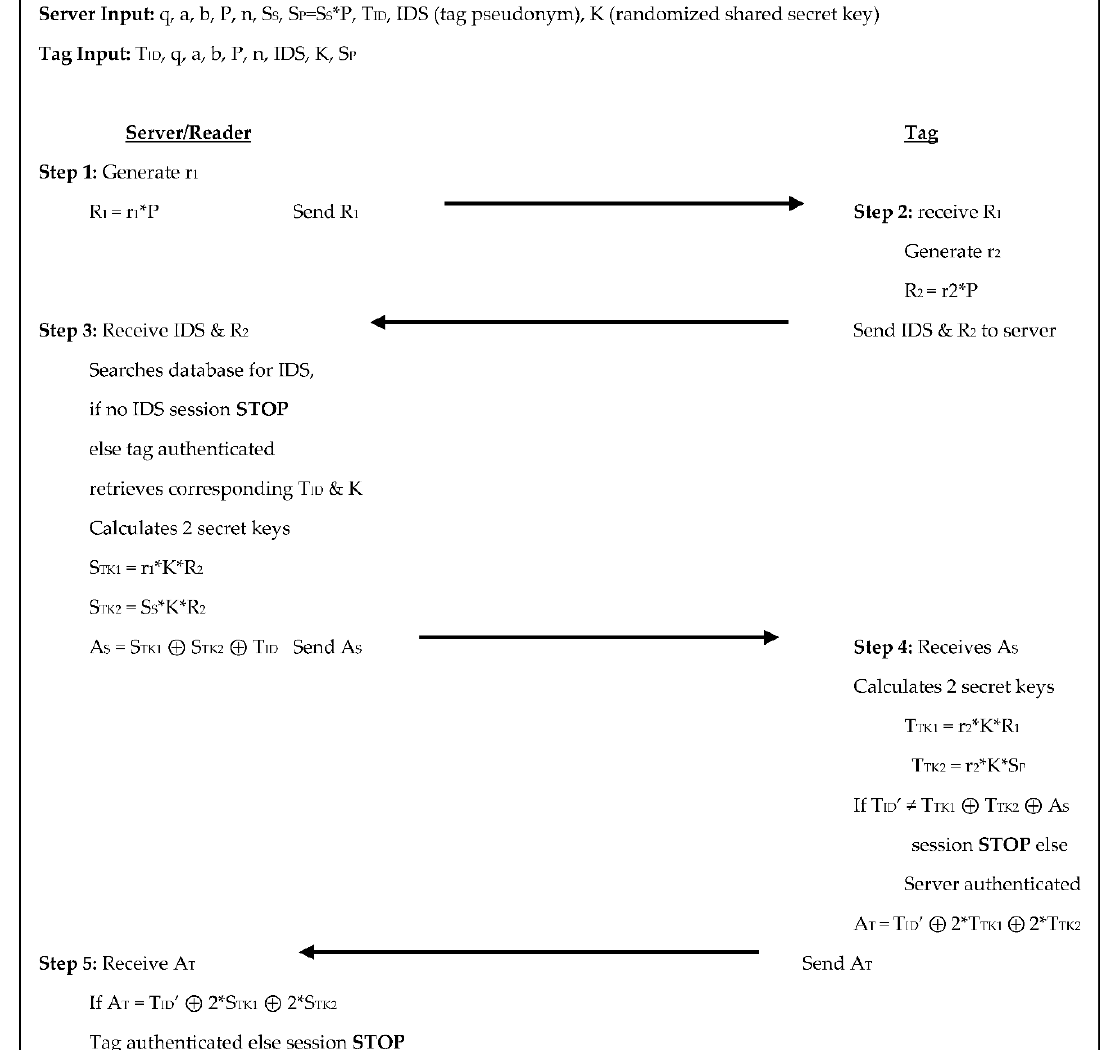
Figure 8. Authentication phases for Dinarvand et al. [17].